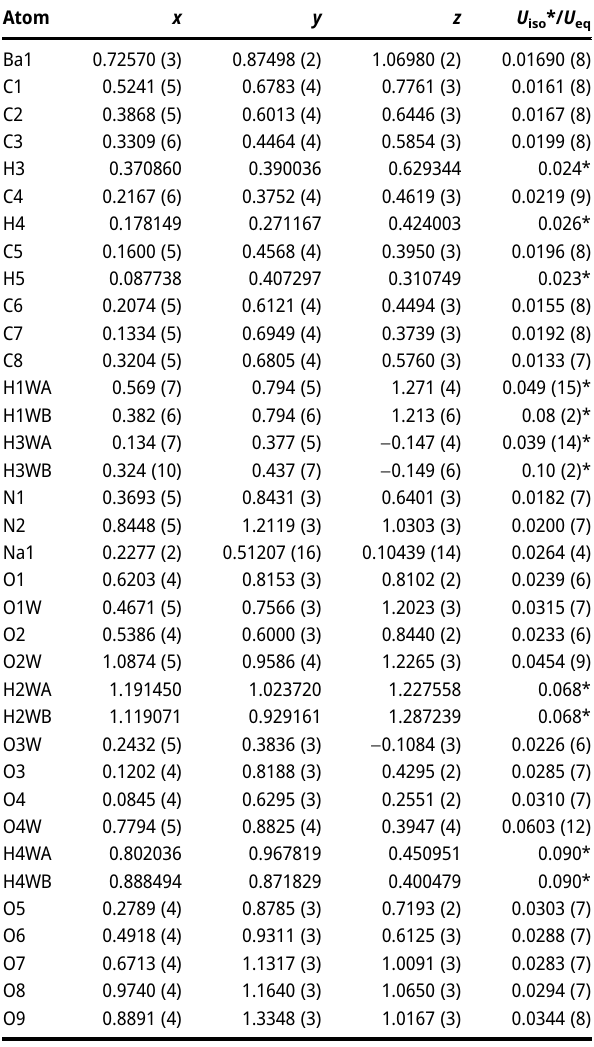
Table  : Fractional atomic coordinates and isotropic or equivalent isotropic displacement parameters (Å 